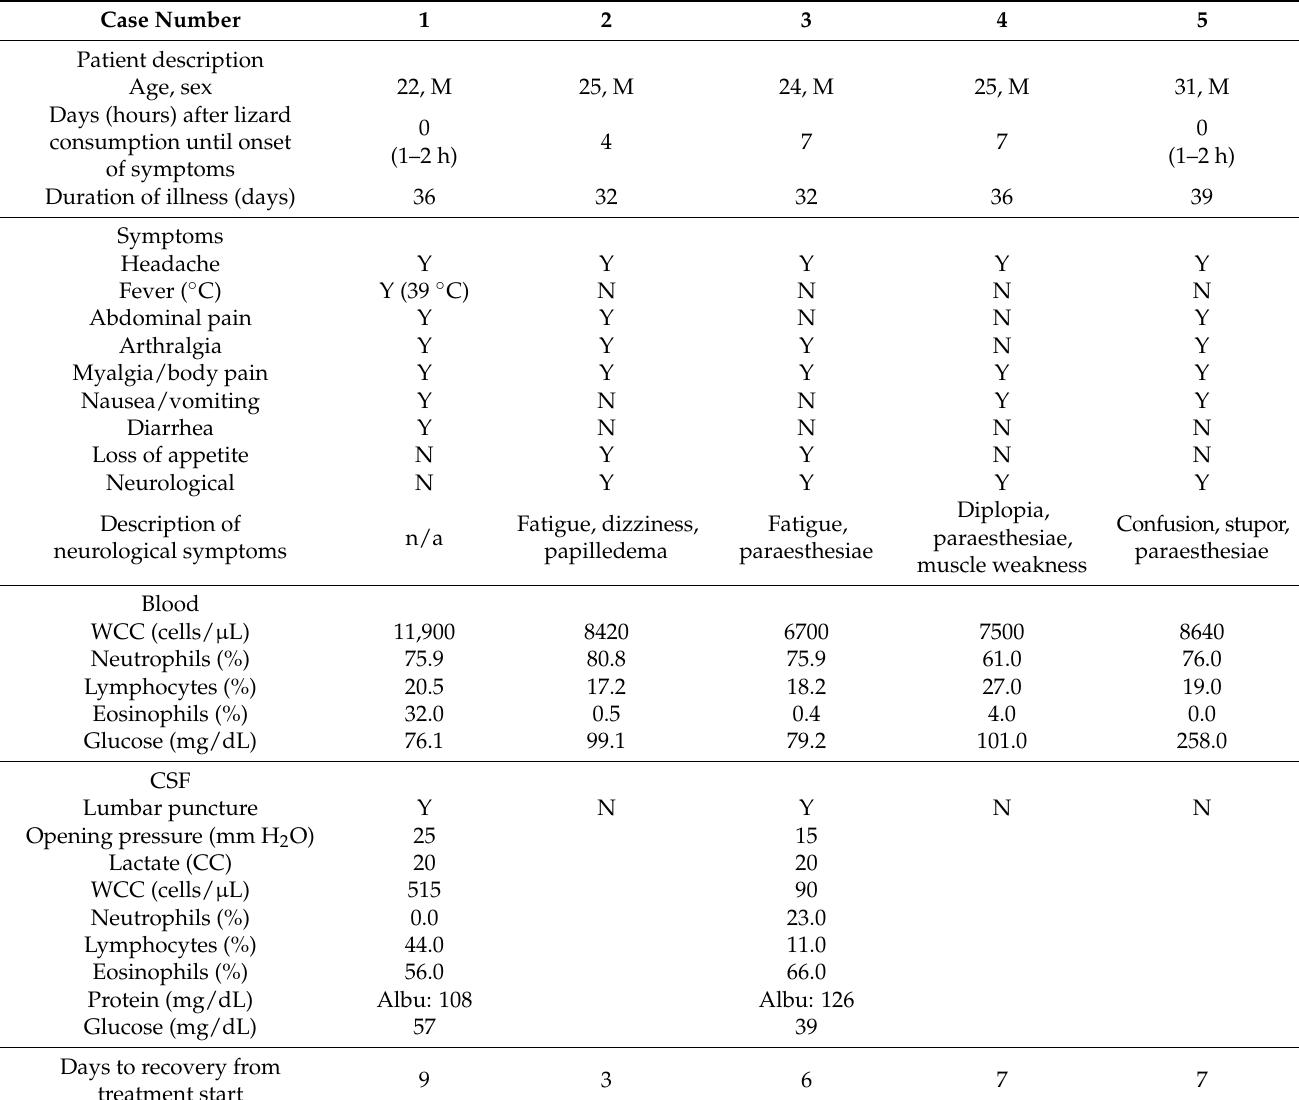
Table 1. Symptoms and clinical description of cases 1 to